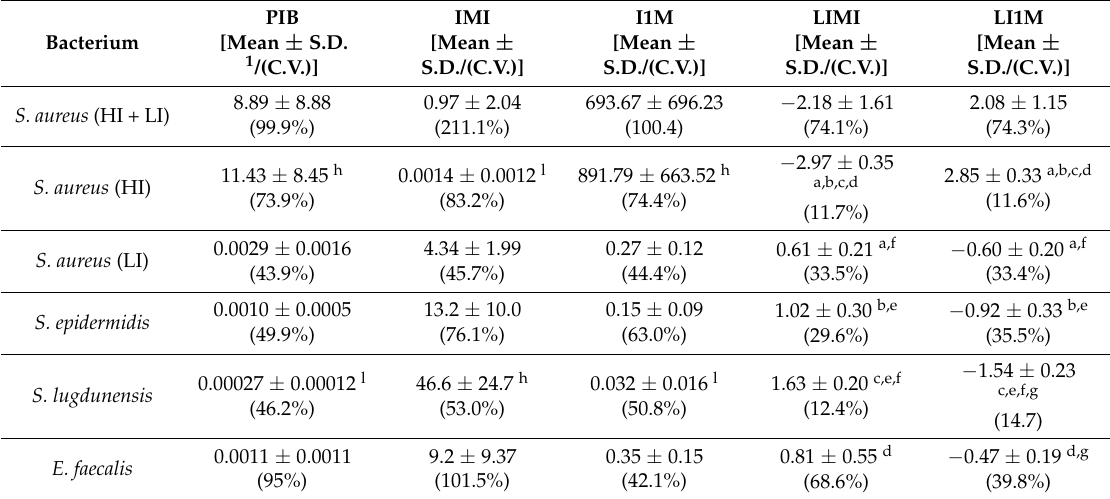
Table 5. Invasiveness of the different bacterial species through old (PIB) and new